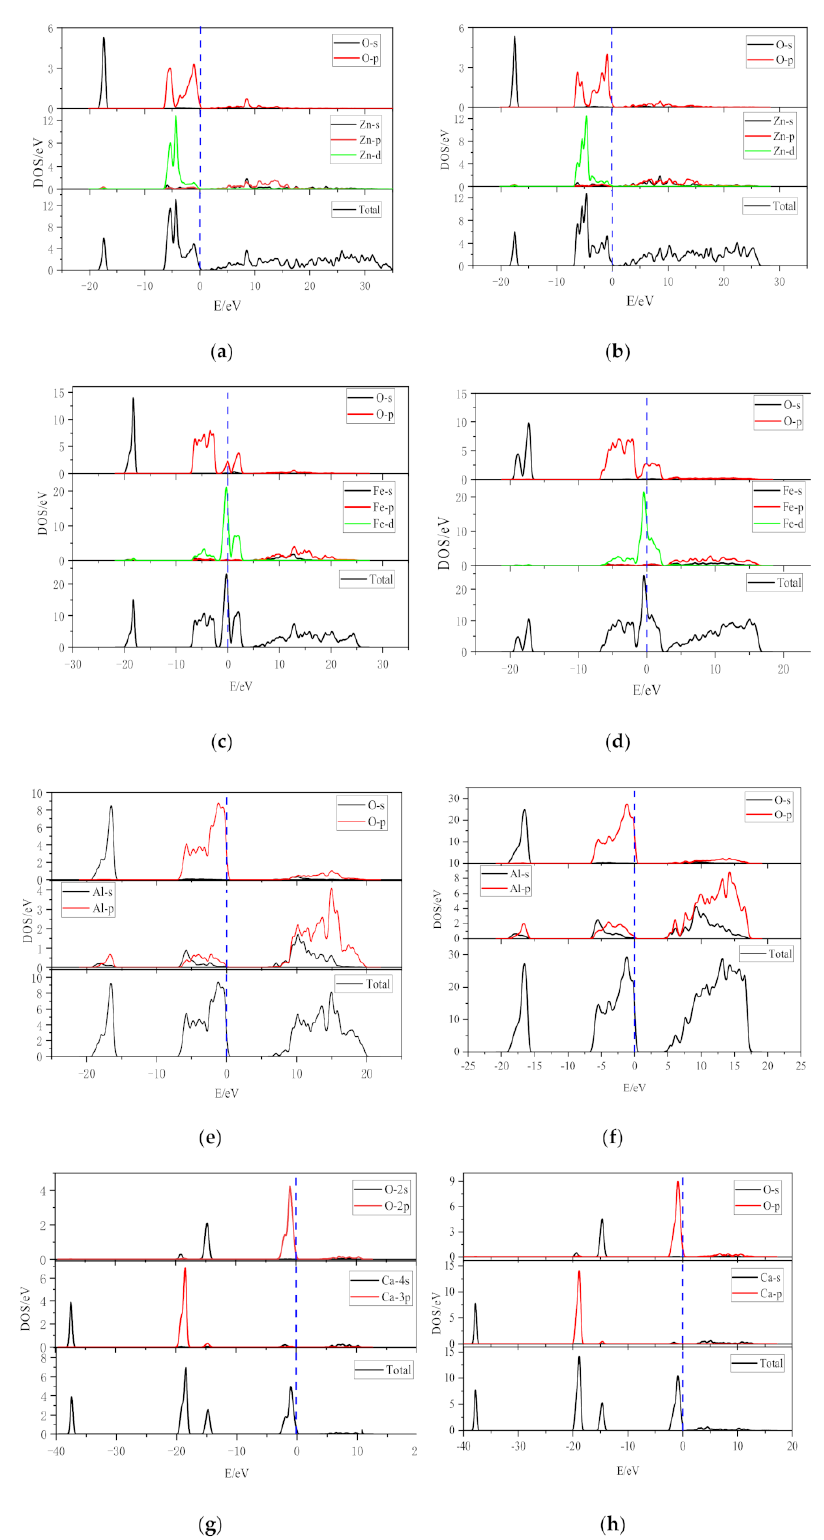
Figure 1. Density of states contrast diagram of metal oxides. Comparison of ZnO density of states (( a ): ZnO cell ( b ): ZnO (001) surface). Comparison of Fe 2 O 3 density of states (( c ): Fe 2 O 3 cell ( d ): Fe 2 O 3 (001) surface). Comparison of Al 2 O 3 density of states (( e ): Al 2 O 3 cell ( f ): Al 2 O 3 (001) surface. Comparison of CaO density of states (( g ): CaO cell ( h ): CaO (001)